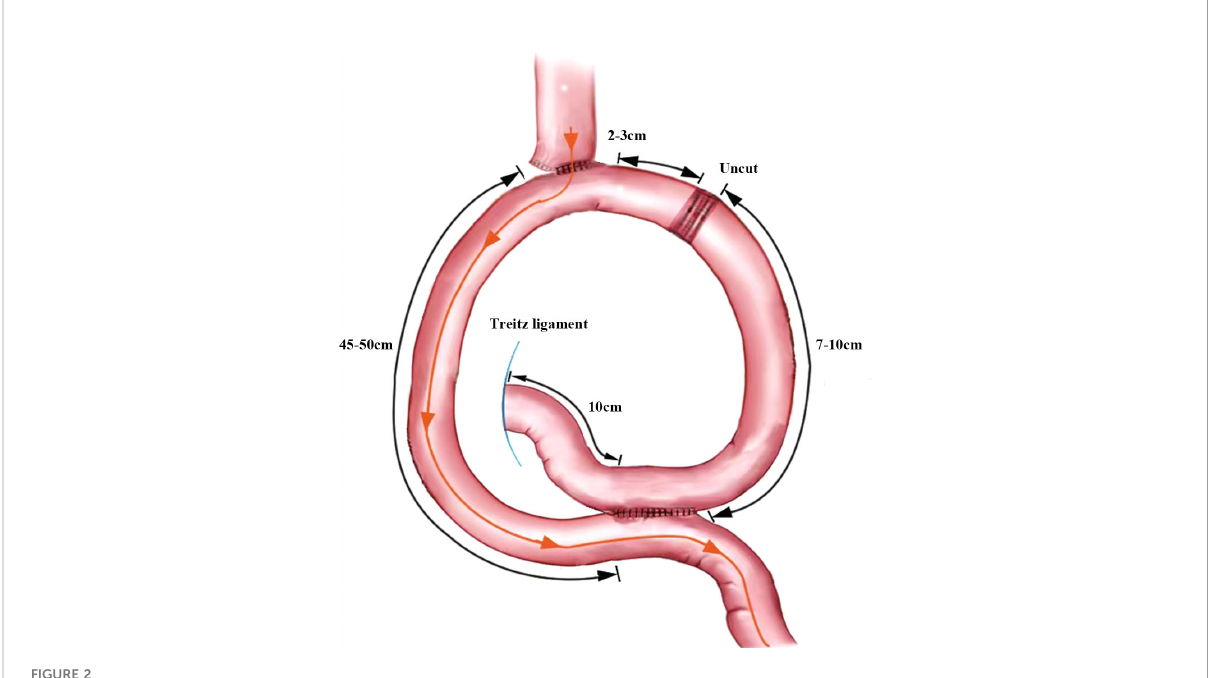
FIGURE 2 URY anastomosis diagram Orange arrows indicate the direction of food fl